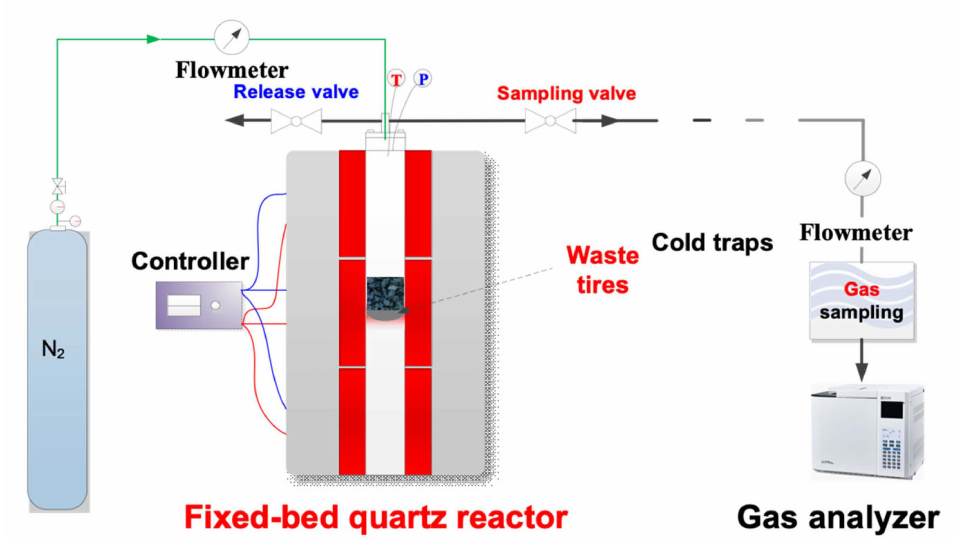
Figure 1. Schematic diagram of tire